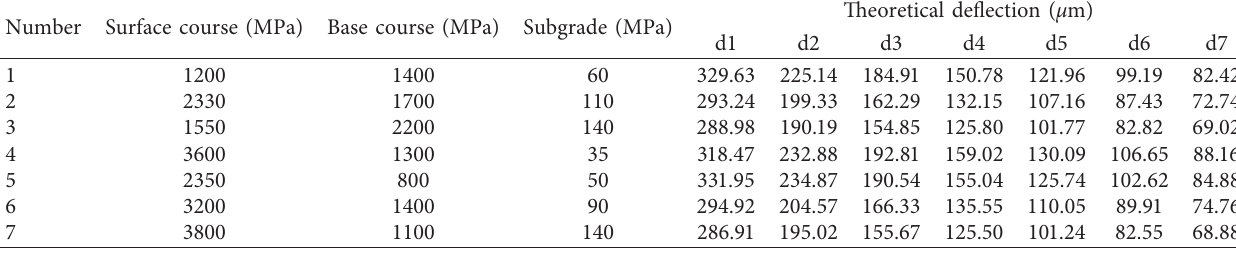
Table 2: Seven sets of deflection basin data.